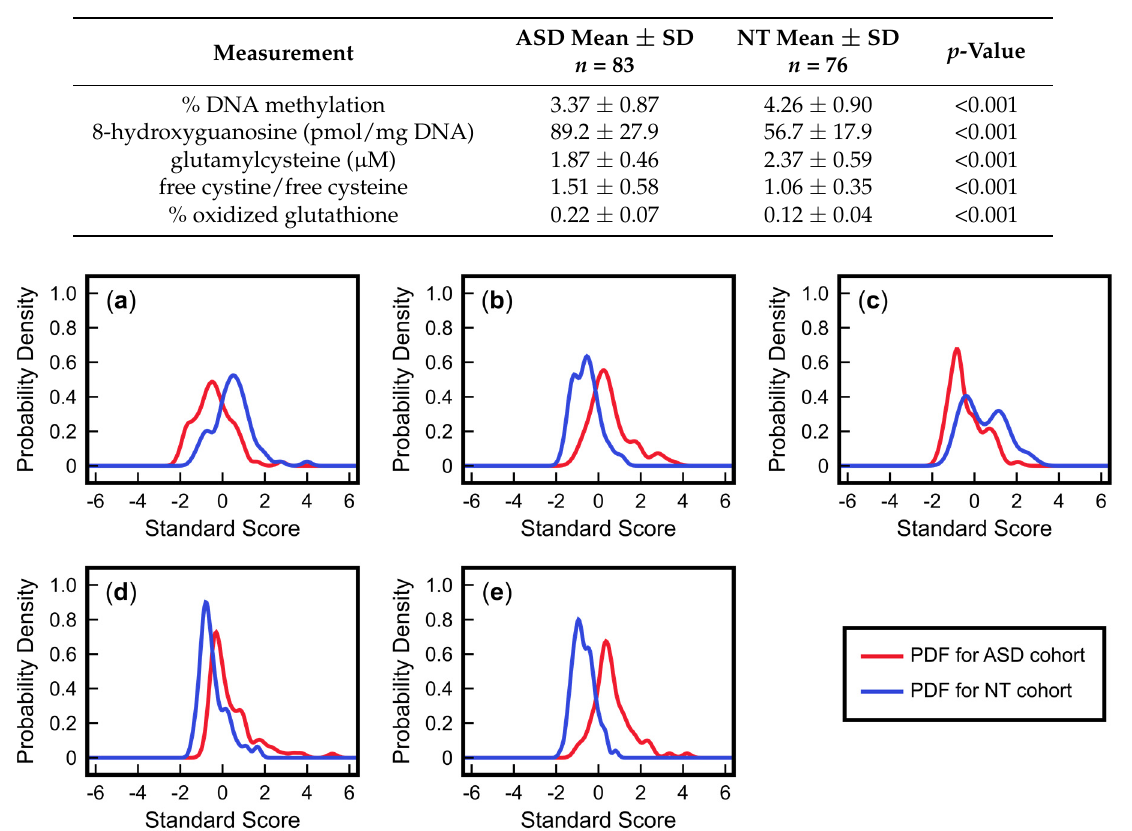
Figure 4. Probability density functions (PDFs) of five measurements for ASD and NT cohorts from the IMAGE study: ( a ) % DNA methylation; ( b ) 8-hydroxyguanosine; ( c ) glutamylcysteine; ( d ) free cystine/free cysteine; ( e ) % oxidized glutathione. These PDFs are based on the standardized values of each measurement (i.e., all samples for a measurement are scaled such that the mean value is 0 and the standard deviation is 1).